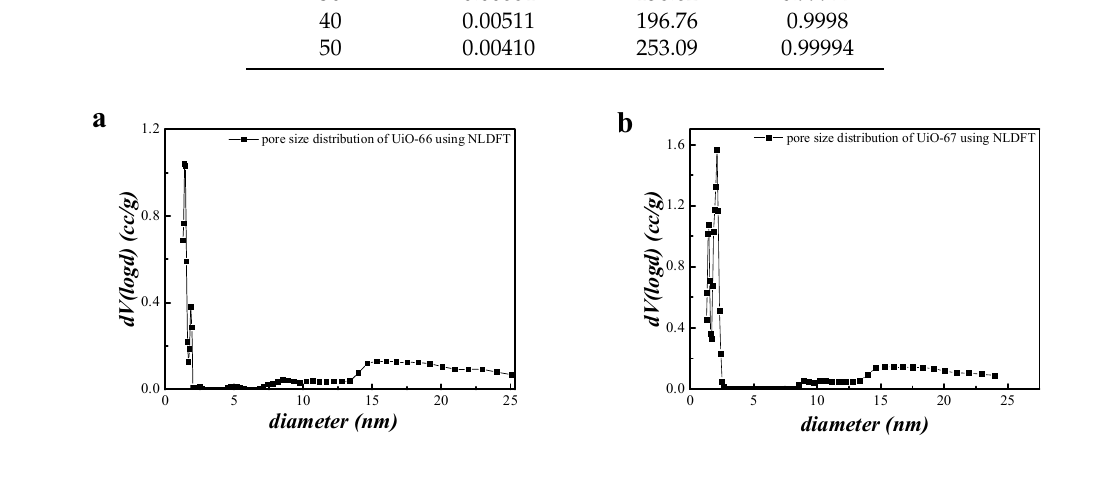
Table 2. Parameters of pseudo-second-order kinetics model for the adsorption of AO7 by UiO-67 at series initial concentrations.